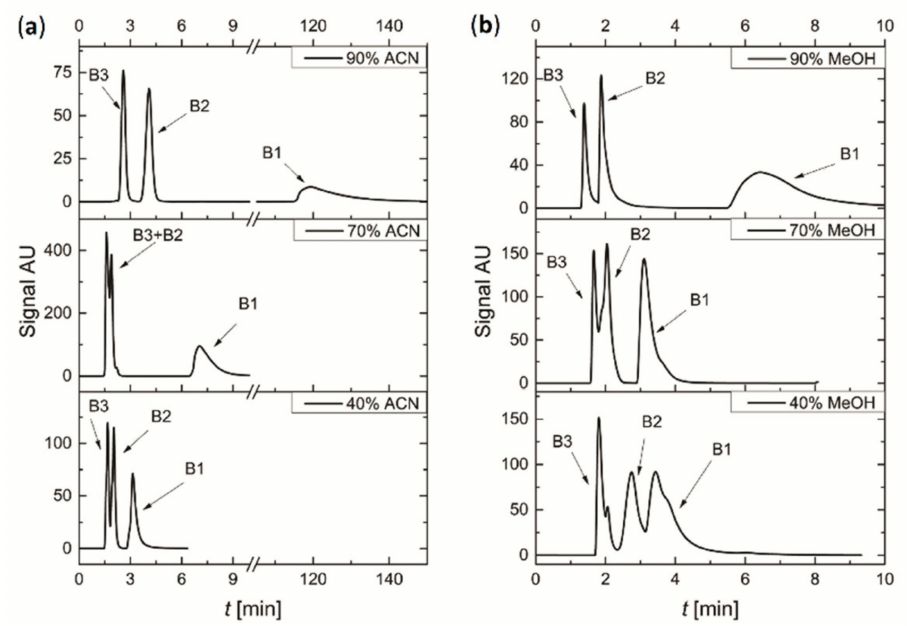
Figure 7. Preliminary results of separation of vitamin mixture obtained using column A (Acclaim™ Mixed–Mode HILIC 1) with: ( a ) acetonitrile–ammonia acetate buffer (10 mmol/dm 3 , pH 5) and ( b ) methanol–ammonia acetate buffer (10 mmol/dm 3 , pH 5) as mobile